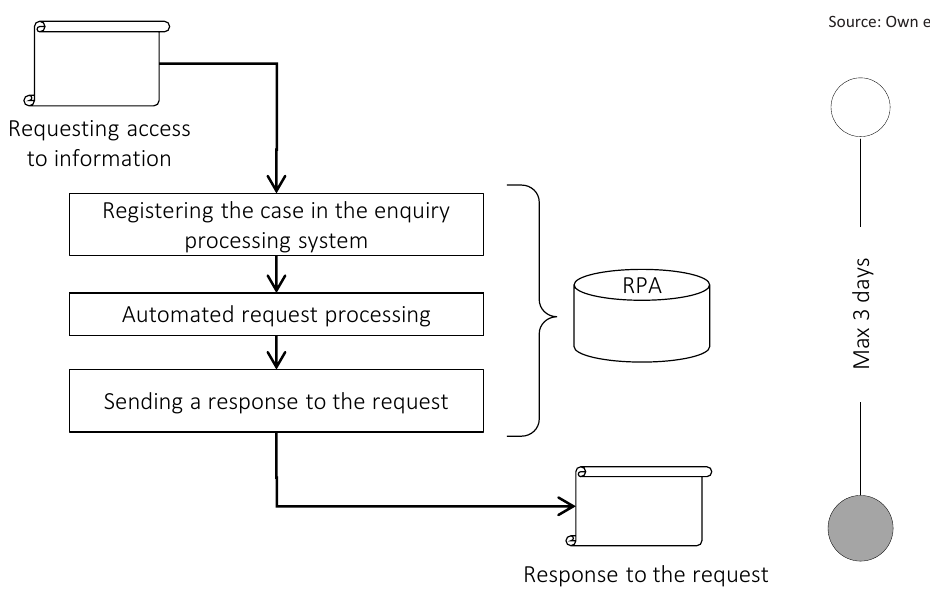
Figure 2. The process of provision of information constituting a bank secret with the use of the RPA tool